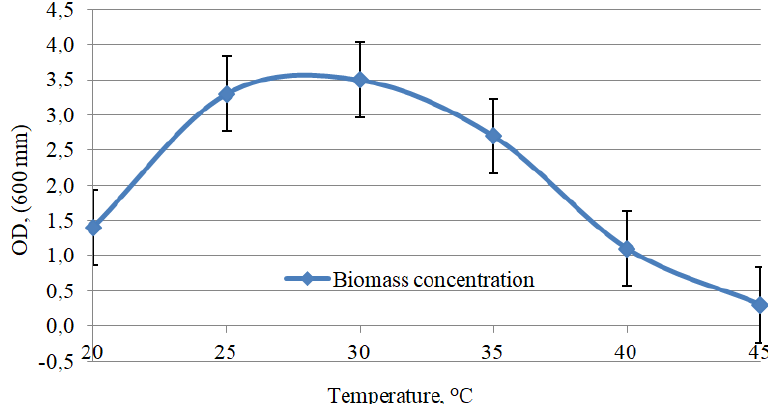
Figure 4. Effect of temperature on biomass accumulation: Consortium D.